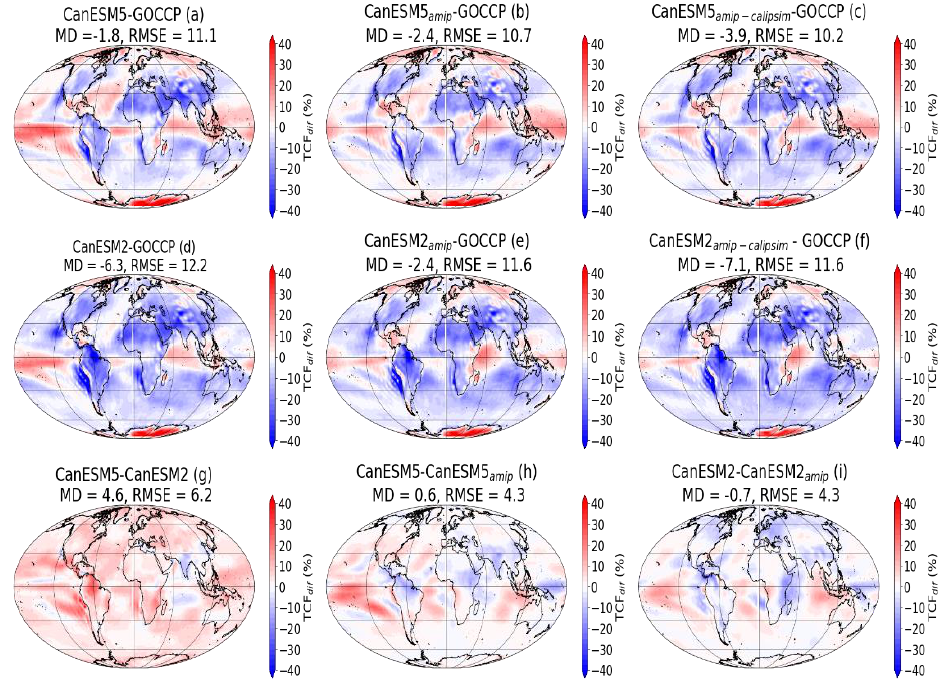
Figure 2. The global maps of model bias in annually averaged total cloud fraction (TCF). The root mean square error (RMSE) and mean difference (MD) values are also given.